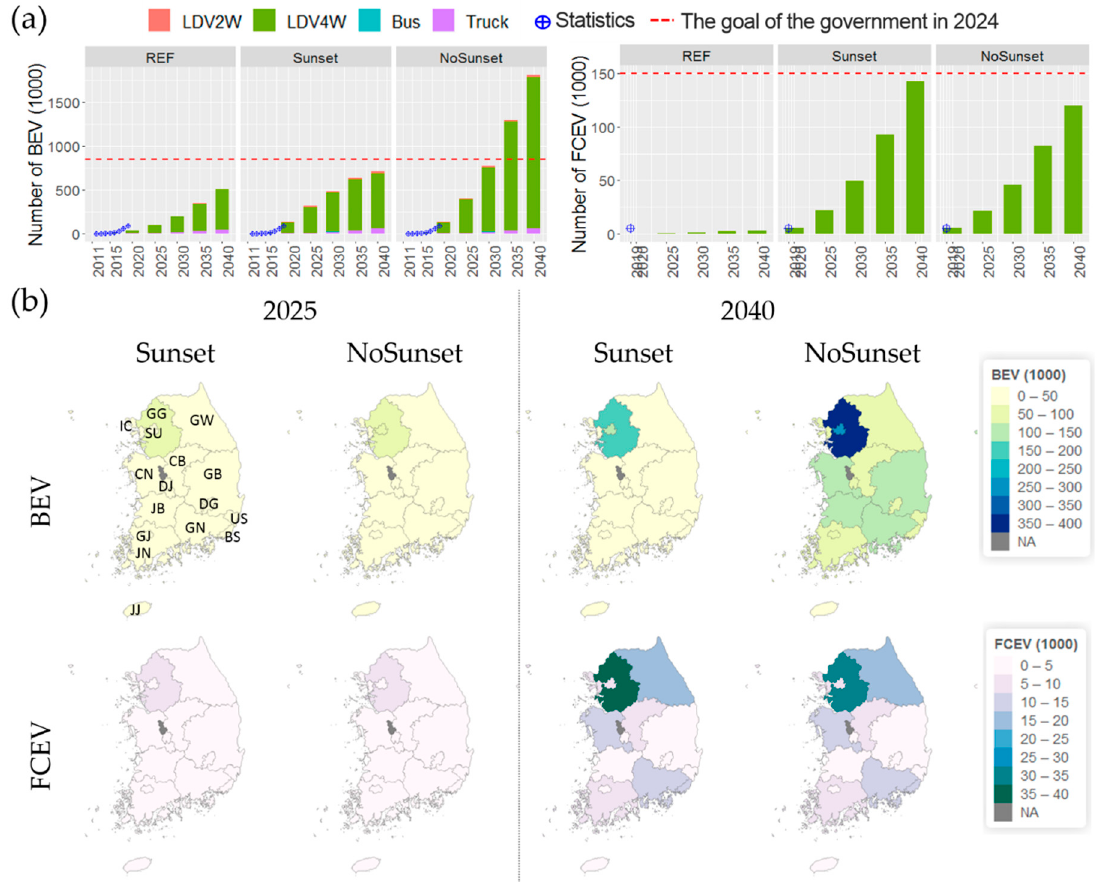
Figure 6. Estimates of the cumulative number of ZEVs by sector ( a ) and by province ( b ).